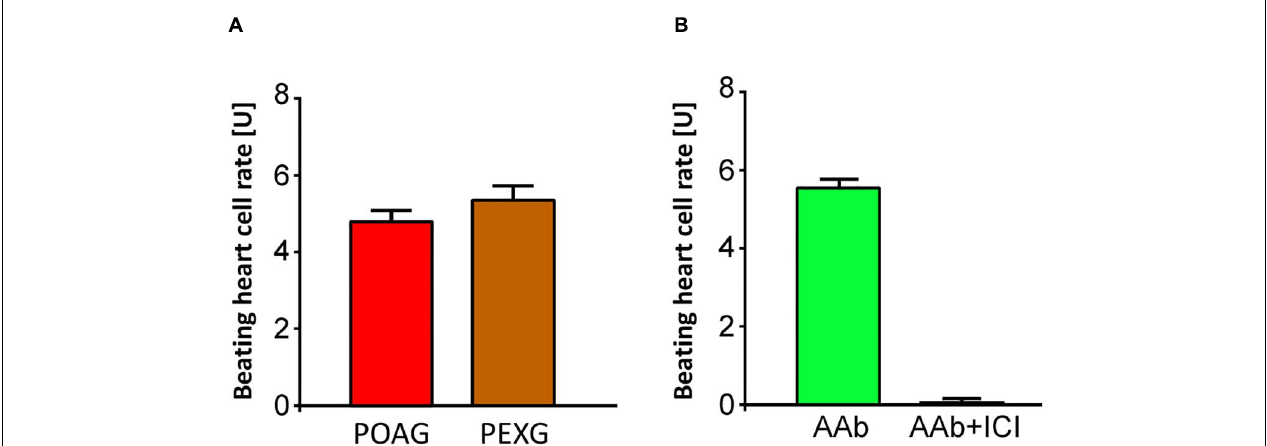
FIGURE 5 | Agonistic β 2 -agAAbs in sera of open-angle glaucoma. (A) Beating heart cell rates after incubation with sera of patients with primary open-angle glaucoma (POAG, red) and PEX glaucoma (PEXG, orange); mean ± standard deviation (SD); 1 unit (U) reflects 4 beats/min. An increase of the beating heart cell rate was observed in POAG and PEXG, showing its agonistic effect. Beating heart cell rate of POAG and PEXG did not differ significantly ( p > 0.05). (B) Beating heart cell rates after application of sera without (green) and with ICI-118,551 (black): the agonistic effect of the β 2 -AAbs is shown. The agonistic nature of β 2 -agAAbs activated the receptor with consequent increase of the beating heart cell rate. These agonistic β 2 -agAAbs were observed in sera of patients with open-angle glaucoma.